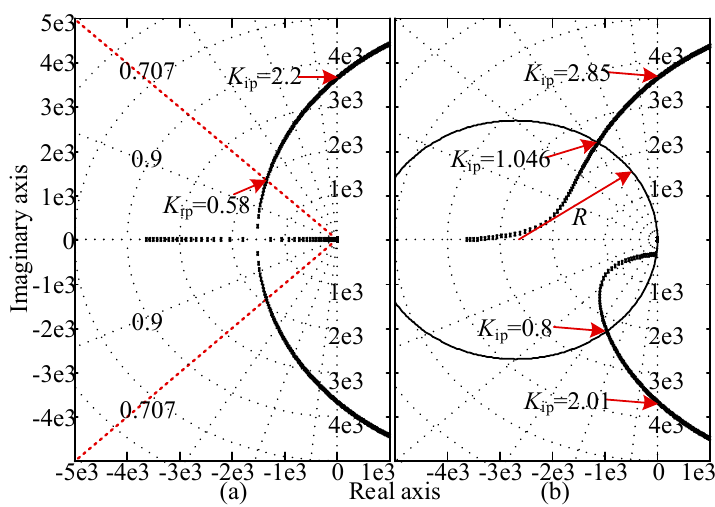
Figure 5. Root locus diagrams with different parameters of G i (s).